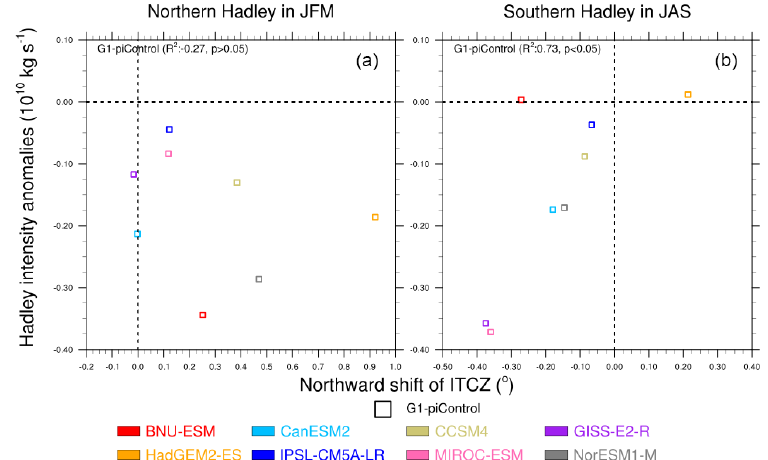
Figure 7. Change in Hadley cell intensity as a function of ITCZ position under G1 relative to piControl across the models for the northern Hadley cell in JFM (a) and the southern Hadley cell in JAS (b) . The ITCZ position is defined from the centroid of precipitation (Smyth et al., 2017).